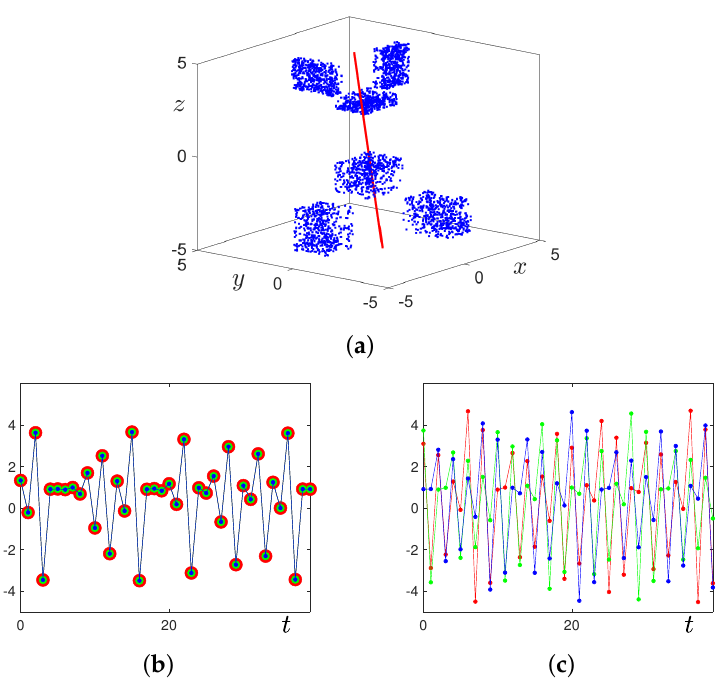
Figure 6. Coexisting chaotic attractors of system (1) for σ = 0.9. ( a ) Projections of coexisting 1-piece synchronous (red line) and 6-piece (blue dots) chaotic attractors on the ( x , y ) plane. Time series of ( b ) completely synchronized chaotic attractor and ( c ) phase synchronized chaotic